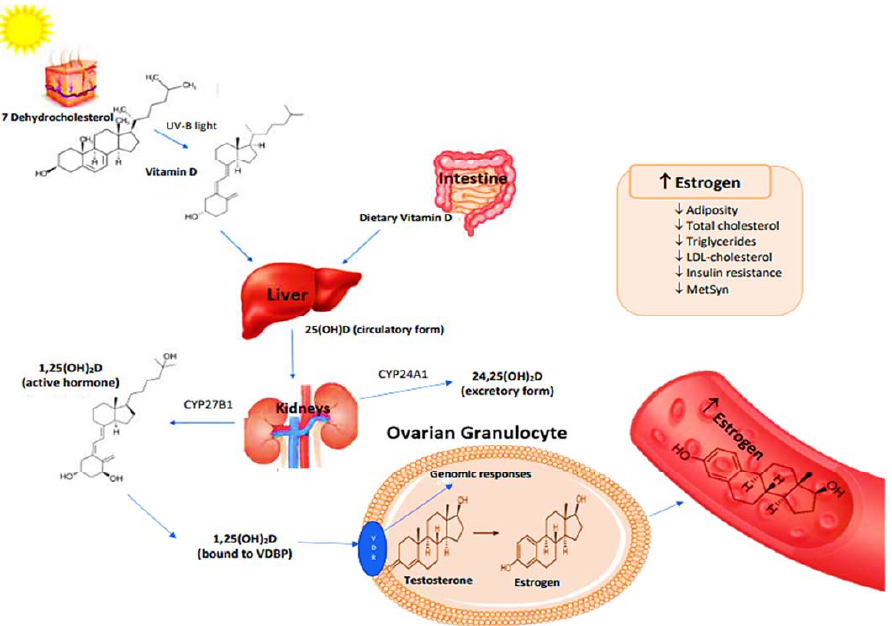
Figure 1. Metabolism of vitamin D ‐ activation and genomic functions [58,59]. Abbreviations: 1,25(OH)2D, 1,25 ‐ dihydroxyvitamin D; 25(OH)D, 25 ‐ hydroxyvitamin D; 24,25(OH)2D, 24,25 ‐ dihy ‐ droxyvitamin D; CYP24A1, cytochrome P450 family 24 subfamily A member 1 or 24 ‐ hydroxylase; CYP27B1, cytochrome P450 family 27 subfamily B member 1 or 1 α‐ hydroxylase, LDL, low ‐ density ‐ lipoprotein; MetSyn, metabolic syndrome.